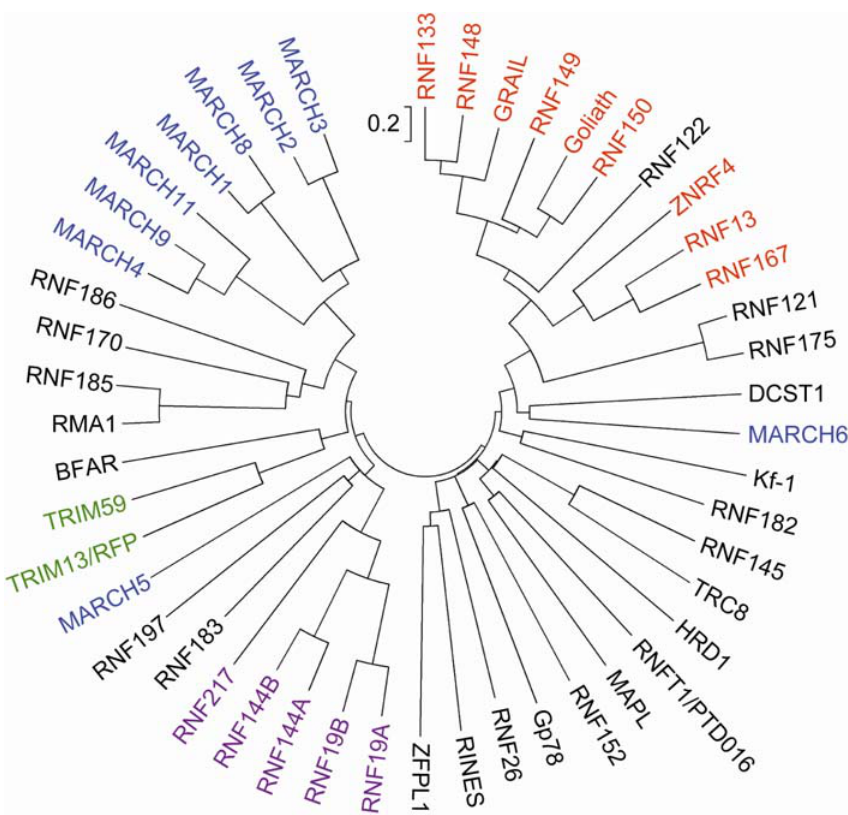
Figure 2. Phylogenetic analysis of putative human transmembrane RNF proteins. The tree was constructed by the neighbor-joining method with ClustalW [22] and MEGA4 [23] using 5,000 bootstrap resamplings. The scale bar indicates 0.2 amino acid substitutions per each amino acid position. Members of the TRIM, PA-TM-RING, MARCH and RBR families are indicated in green, red, blue and purple fonts,